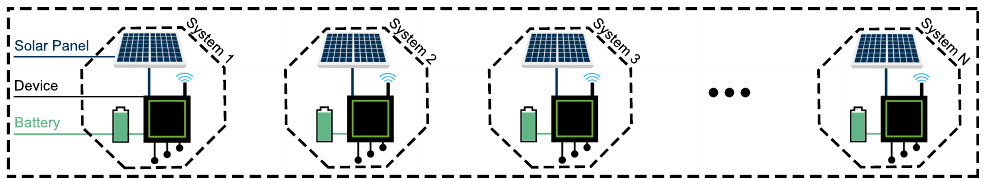
Figure 2. IoT sense